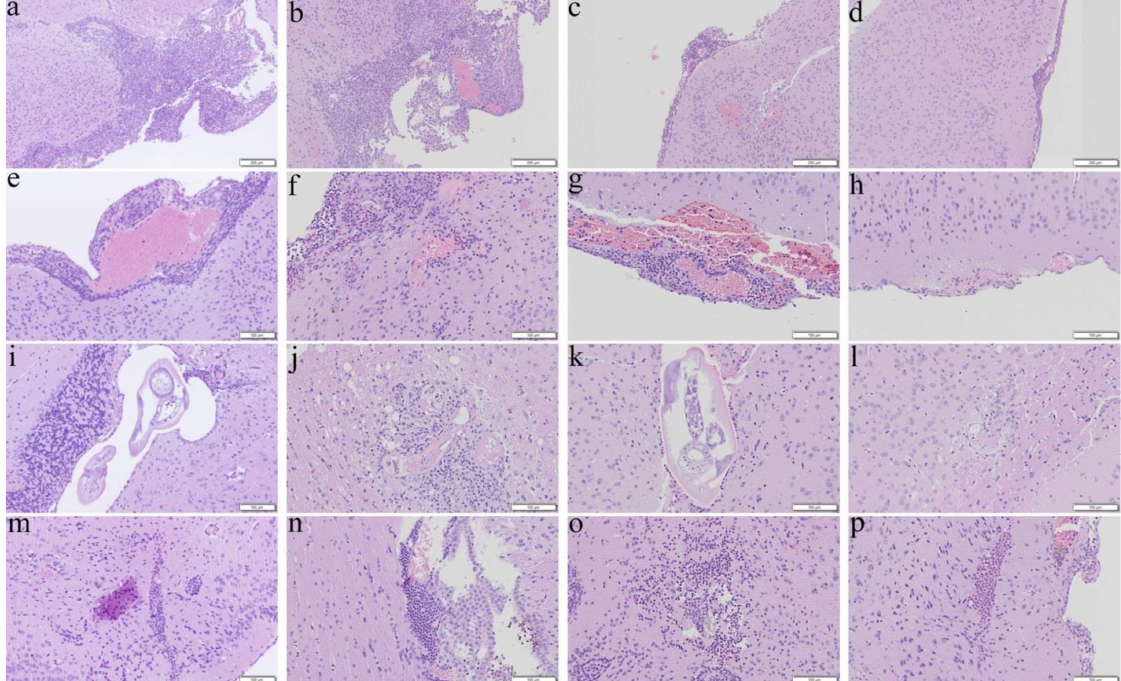
Figure 2. Representative photomicrographs showing meningitis, presence of worms, hemorrhage, and encephalitis in the cerebral parenchyma of the BALB/c mice infected with Angiostrongylus cantonensis treated from day 7 for 14 days. ( a , e , i , m ) Untreated mice. ( b , f , j , n ) Mice treated with albendazole alone. ( c , g , k , o ) Mice treated with dexamethasone alone. ( d , h , l , p ) Co-therapy of albendazole and